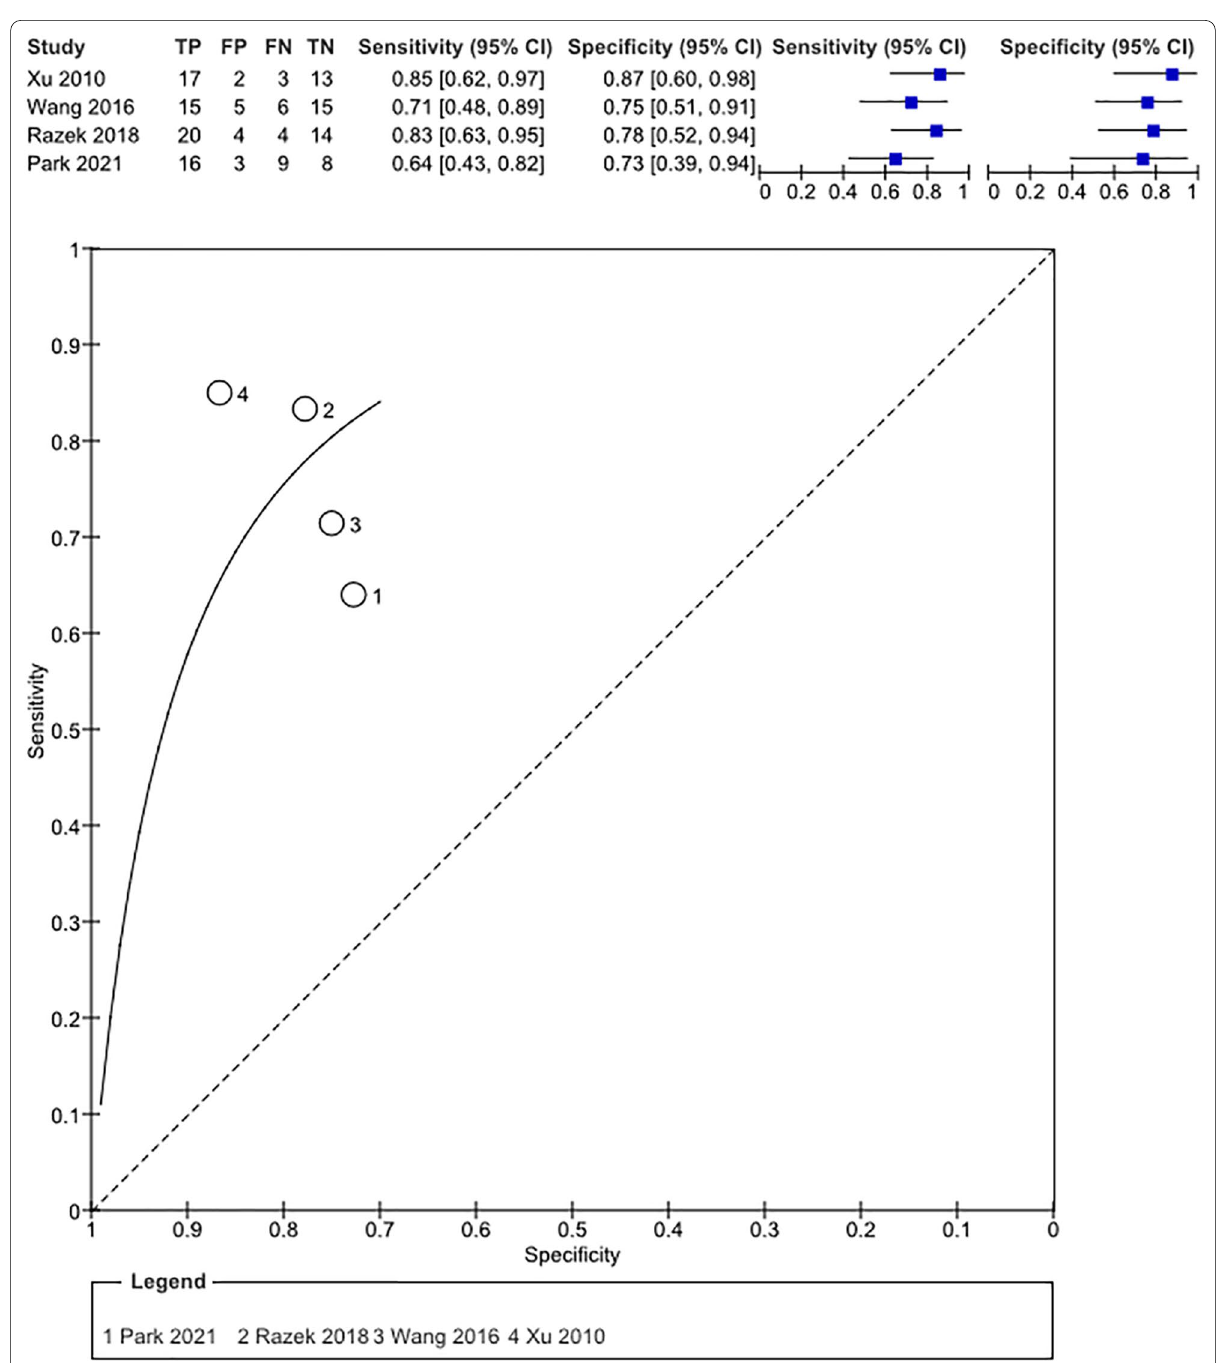
Fig. 6 Summary receiver operator characteristics plot of sensitivity and 1-specificity ratios of the included